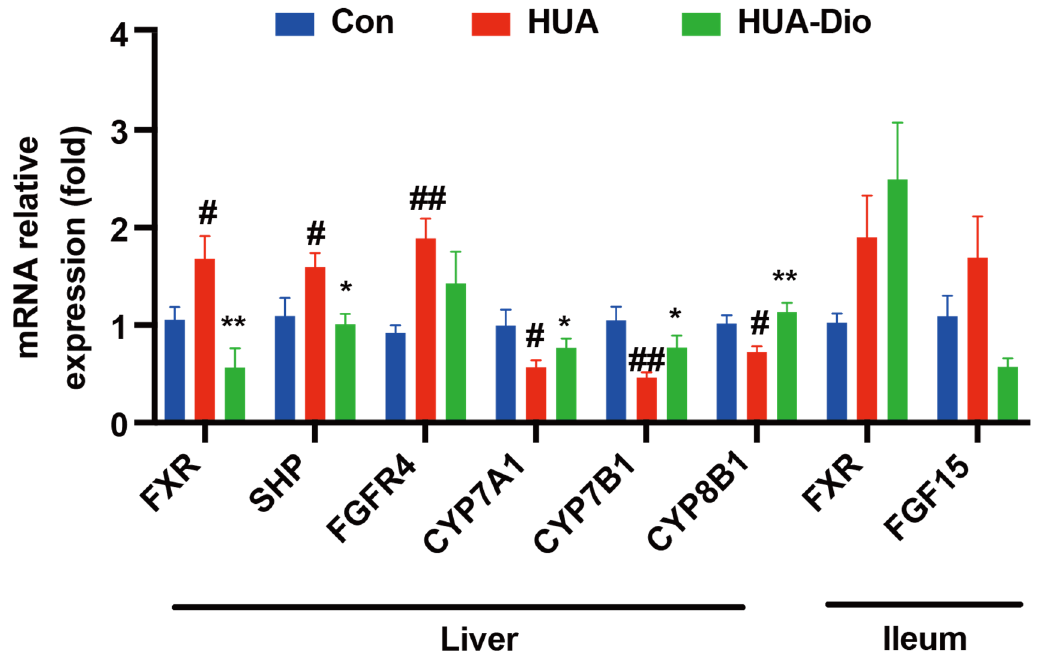
Figure 4. Expression of genes involved in bile acids synthesis in liver and ileum of ApoE − / − mice. Control ApoE − / − mice group (Con), hyperuricemic ApoE − / − mice group (HUA), dioscin-treated hyperuricemic ApoE − / − mice group (HUA-Dio). Data are presented as mean ± S.E.M. # p < 0.05, ## p < 0.01 vs. control ApoE − / − mice group, * p < 0.05, ** p < 0.01 vs. hyperuricemic ApoE − / − mice group.